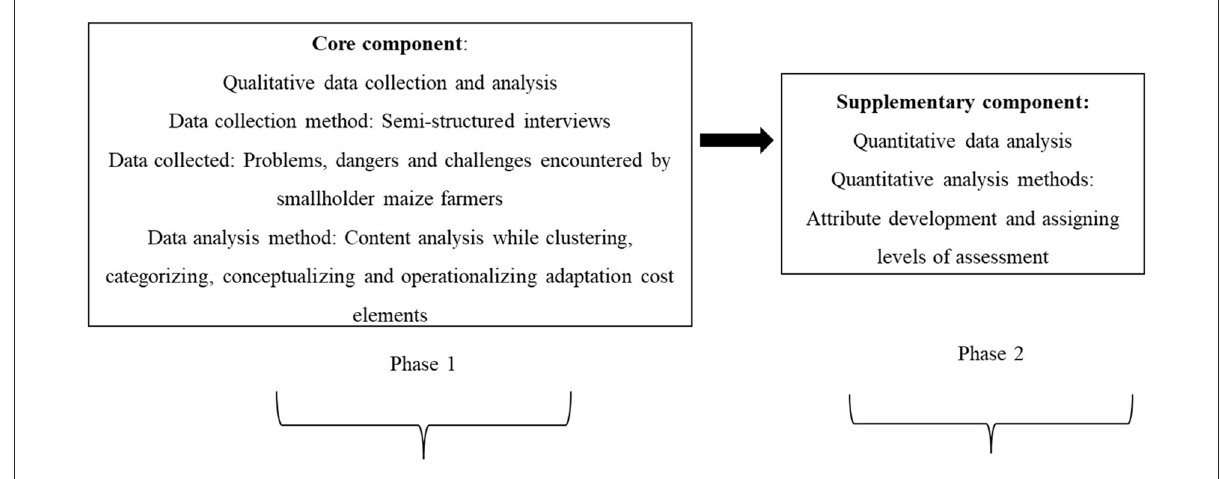
FIGURE2 Research design. Source: Author’s conceptualization.